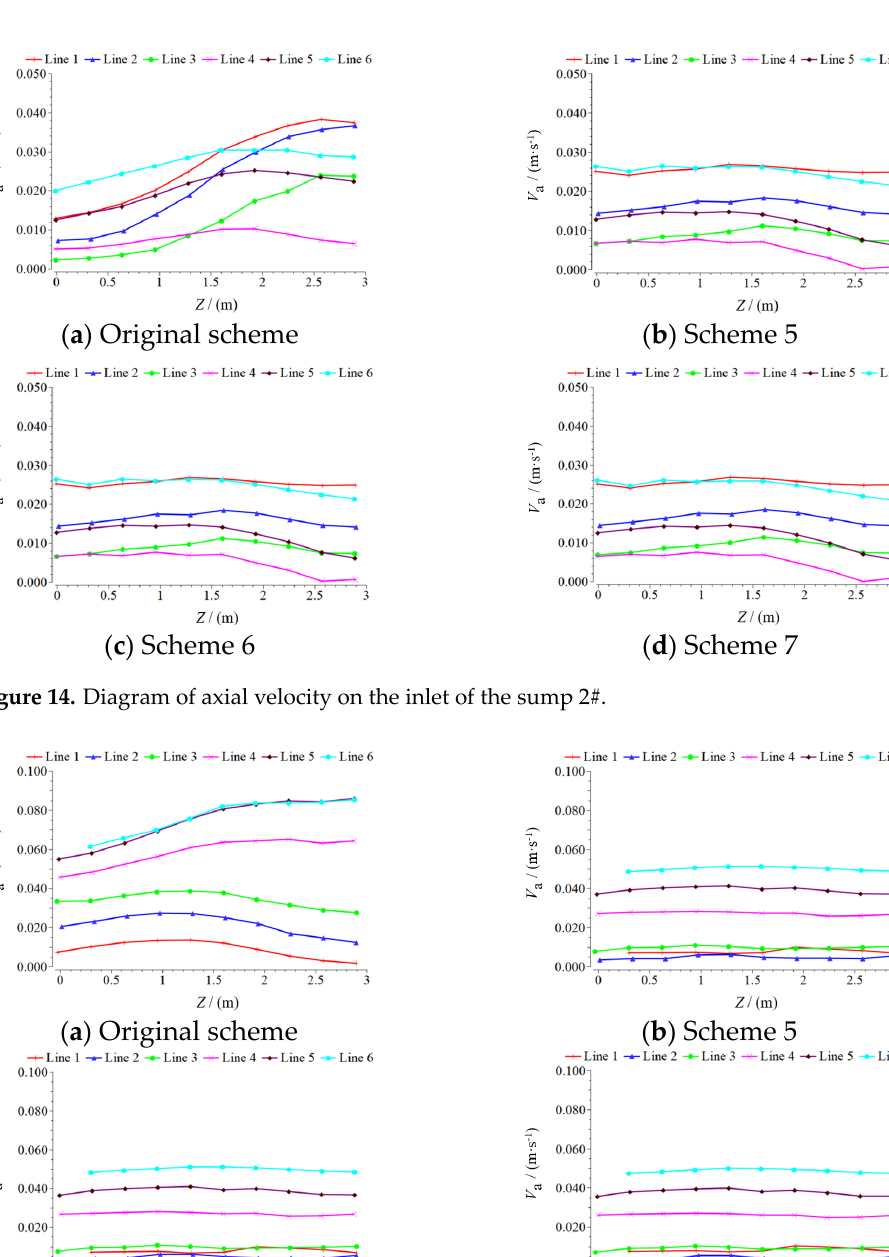
Figure 13. Diagram of axial velocity on the inlet of the sump 1#.